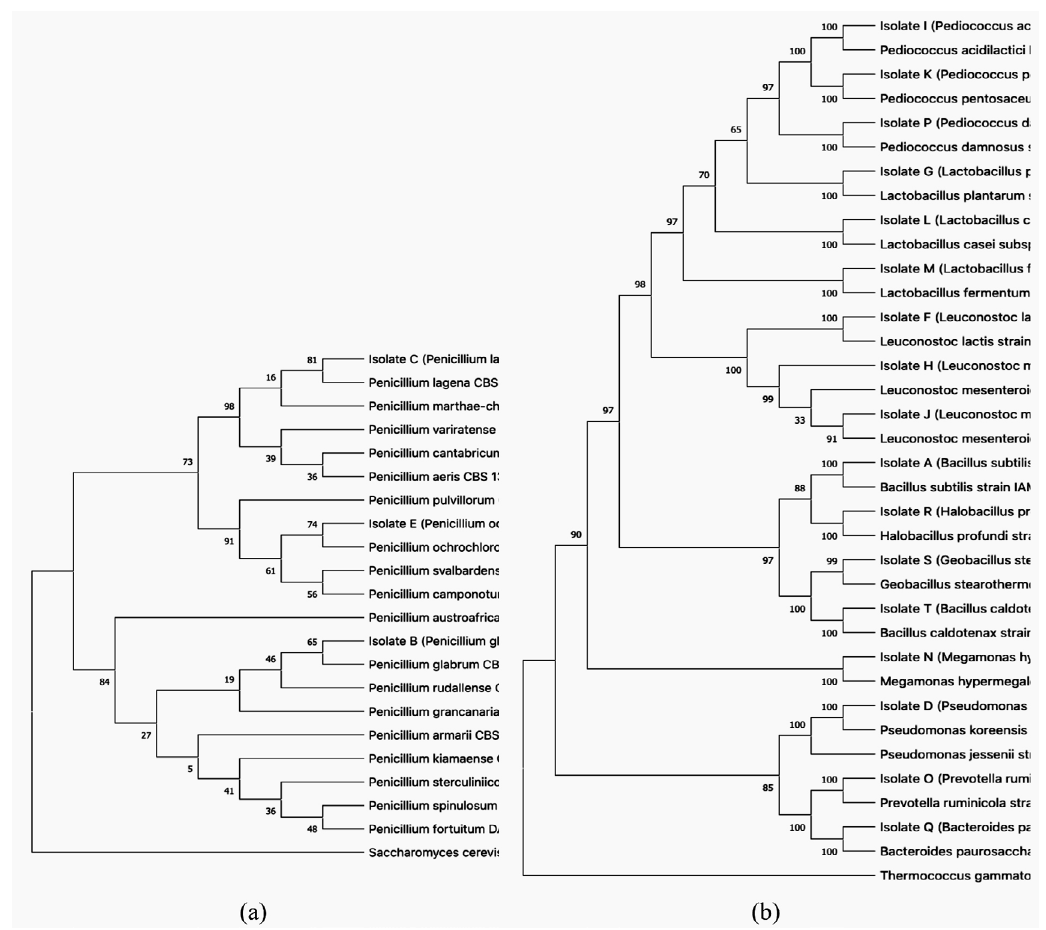
Fig. 1. Phylogenetic tree showing the relative position of fungi isolates based on ITS nrDNA (a) and on 16S rDNA (b) sequences, using the neighbor-joining